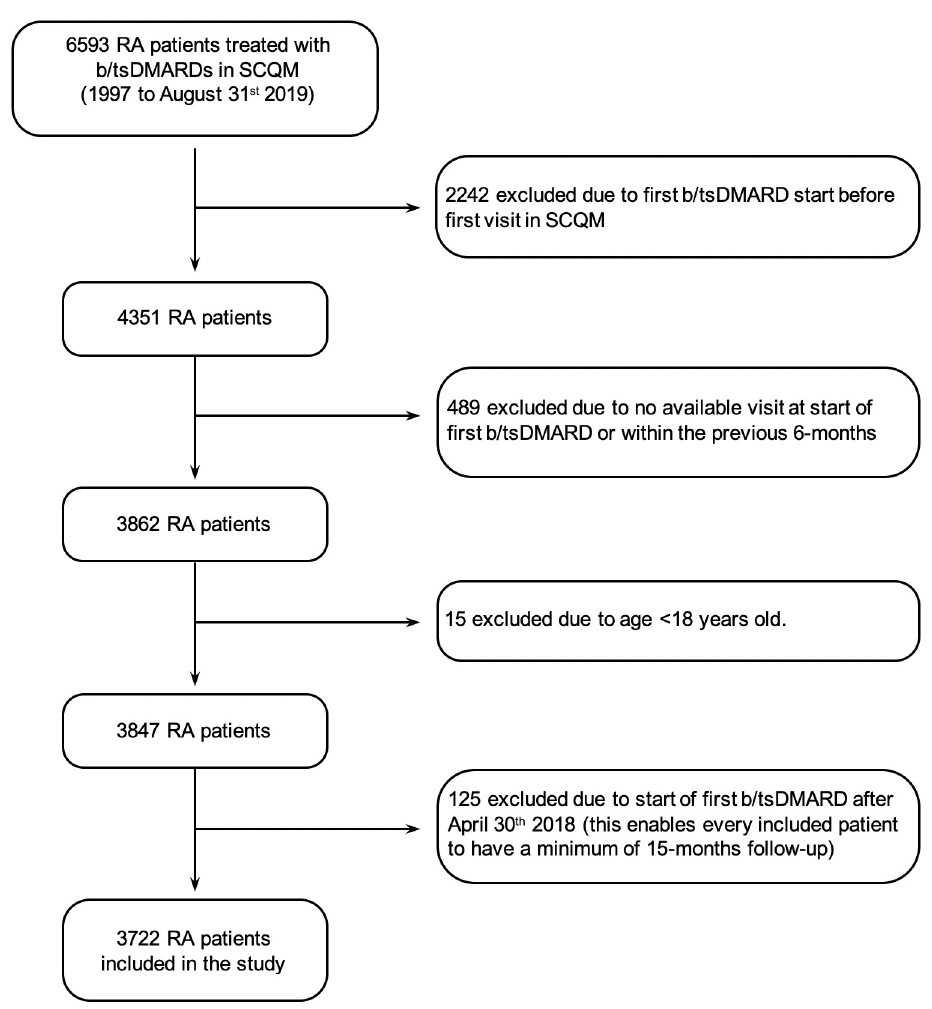
Fig 1. Flowchart of inclusion/exclusion criteria for the study population. Abbreviations: RA rheumatoid arthritis; b/ tsDMARD biologic or targeted synthetic disease-modifying anti-rheumatic drug; SCQM Swiss Clinical Quality Management in Rheumatic